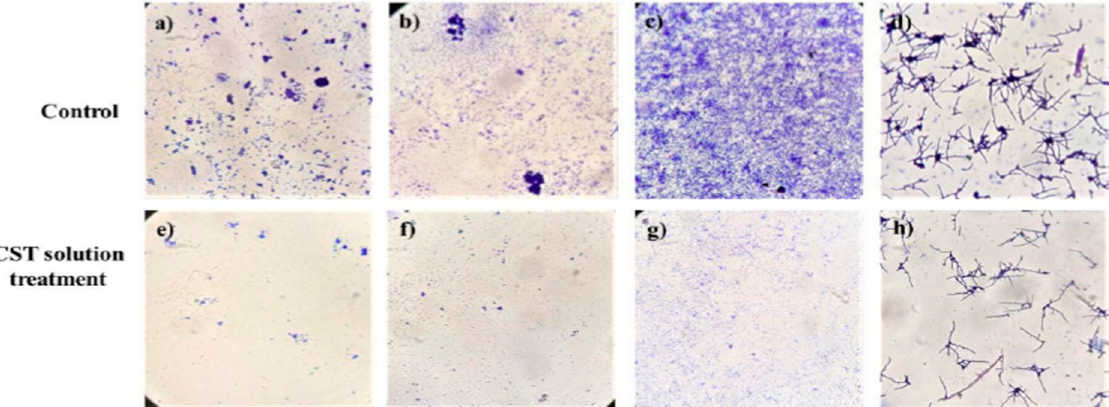
Figure 5. Light microscope images of early biofilms. Biofilm control and biofilm after treatment with CST for 15 min of ( a , e ) S. aureus ATCC 6538, ( b , f ) S. epidermidis ATCC 35984, ( c , g ) P. aeruginosa ATCC 9027, ( d , h ) C. albicans ATCC 10231.